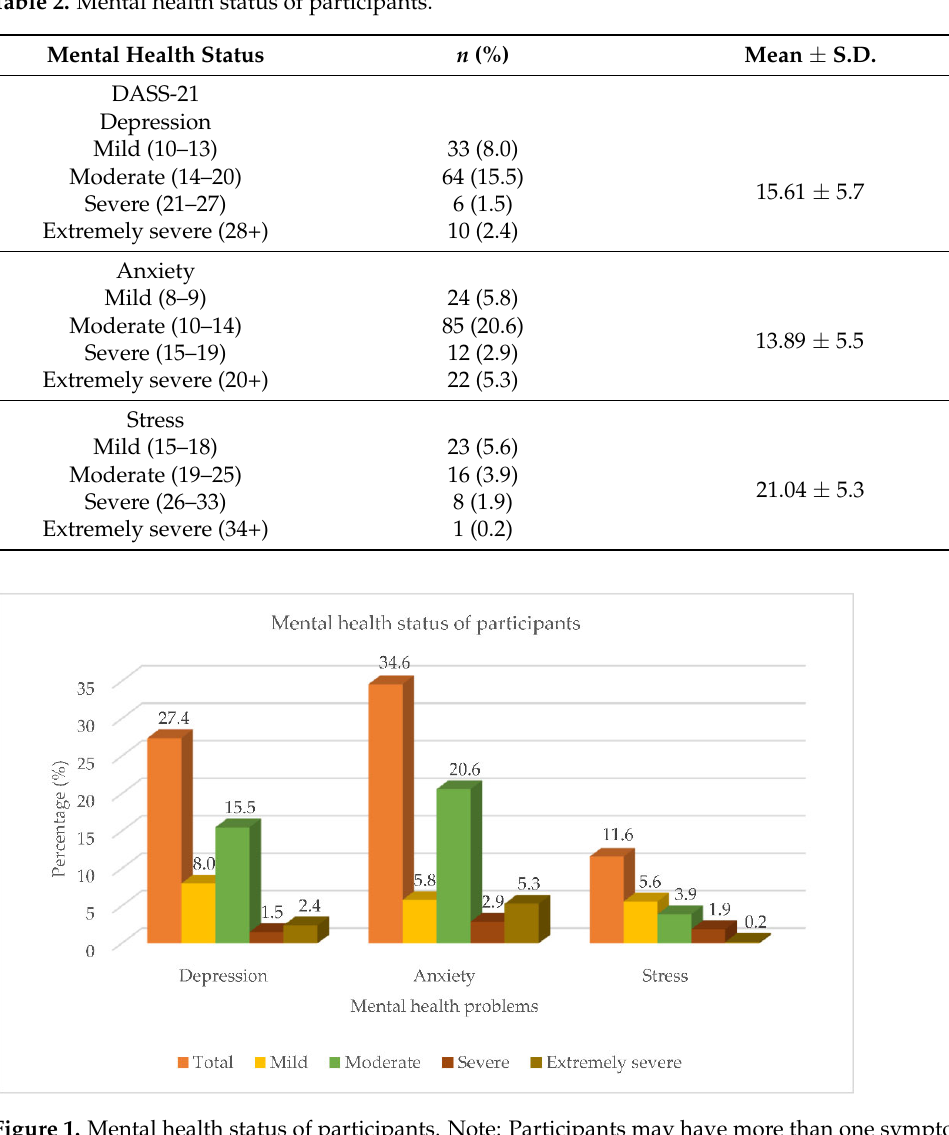
Figure 1. Mental health status of participants. Note: Participants may have more than one symptom of mental health problems.